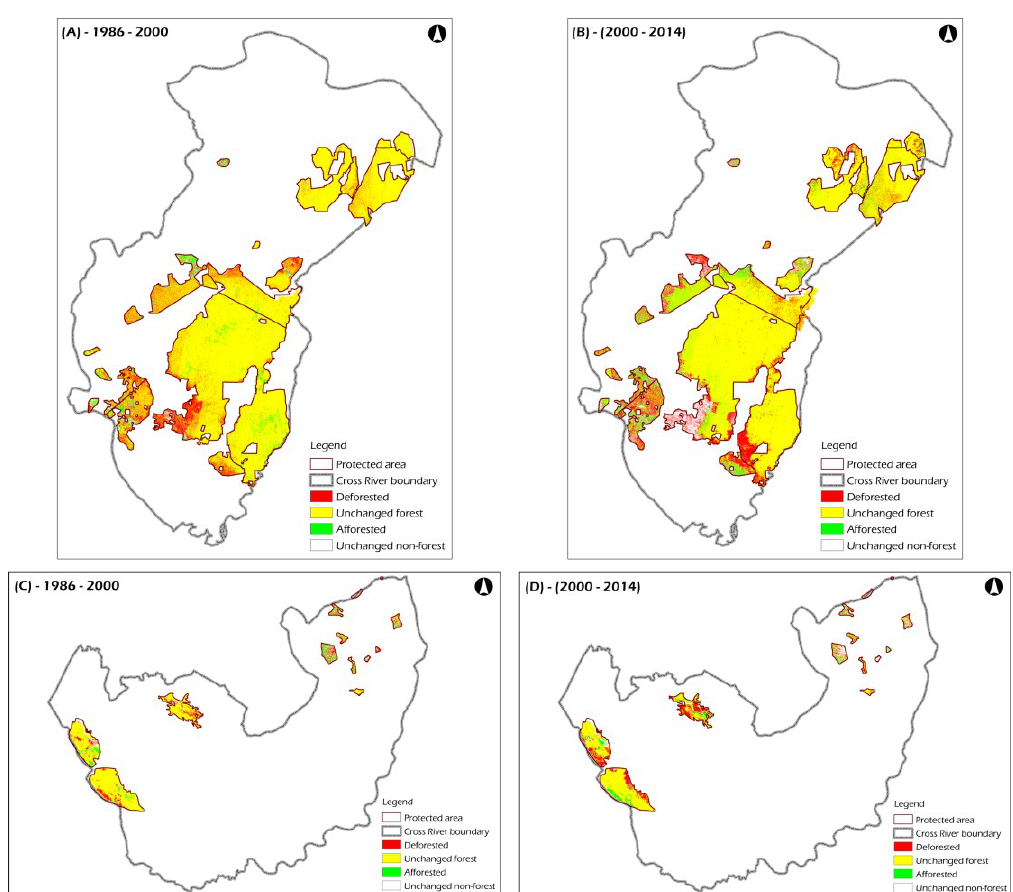
Figure 5. Forest transition maps of protected areas across Cross River ( A and B ) and Delta states ( C and D ) for time periods 1986–2000 and